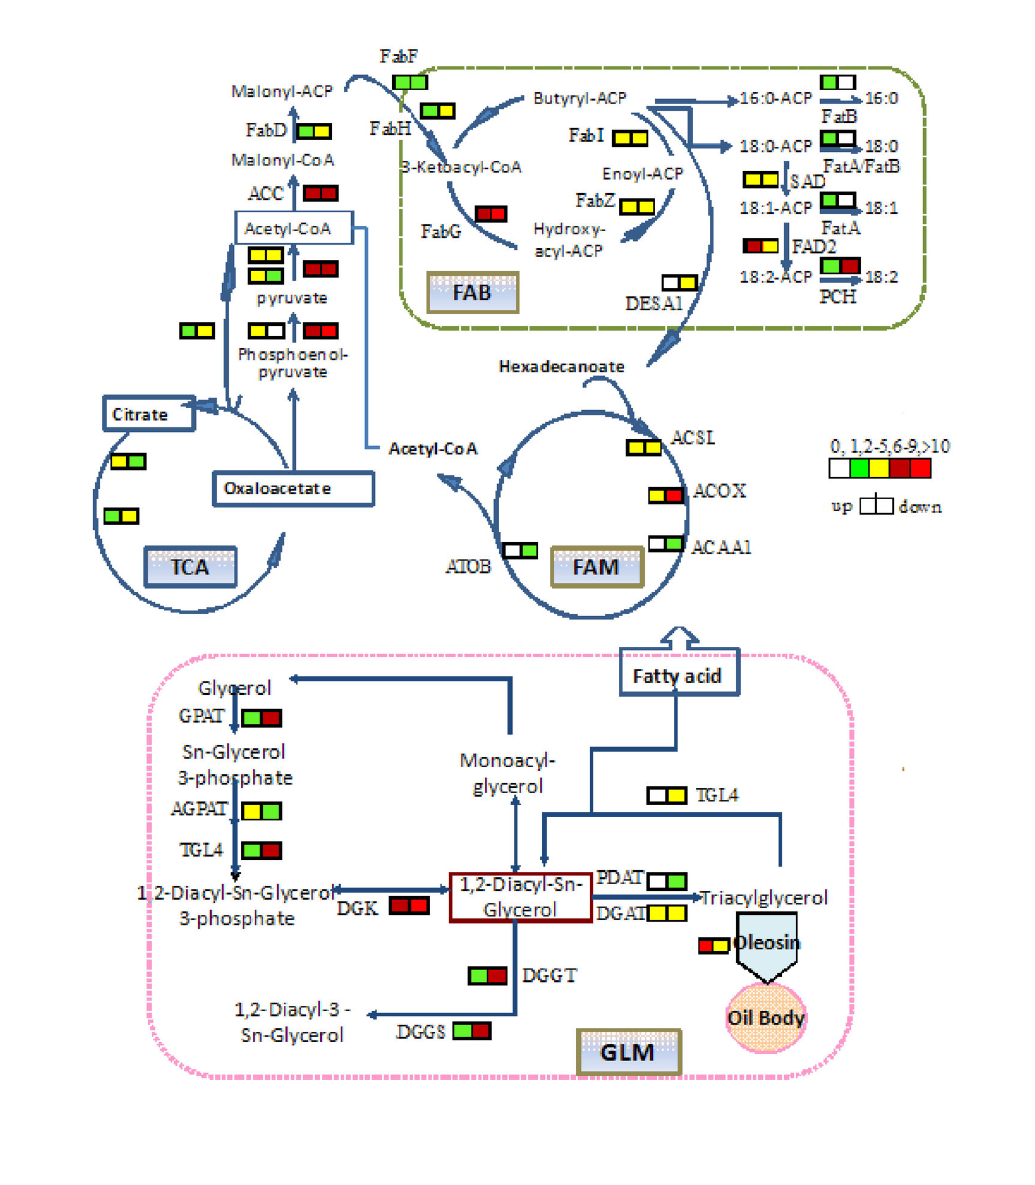
Figure 6. The contrapuntal patterns of unigene expression in developing peanut seeds. Peanut enzymes found in these pathways. The icons beside each enzyme name show the total number of peanut Unigenes corresponding to the enzyme in the seeds. FAB, fatty acid biosynthesis; FAM, fatty acid metabolism; GLM, glycerolipid metabolism.